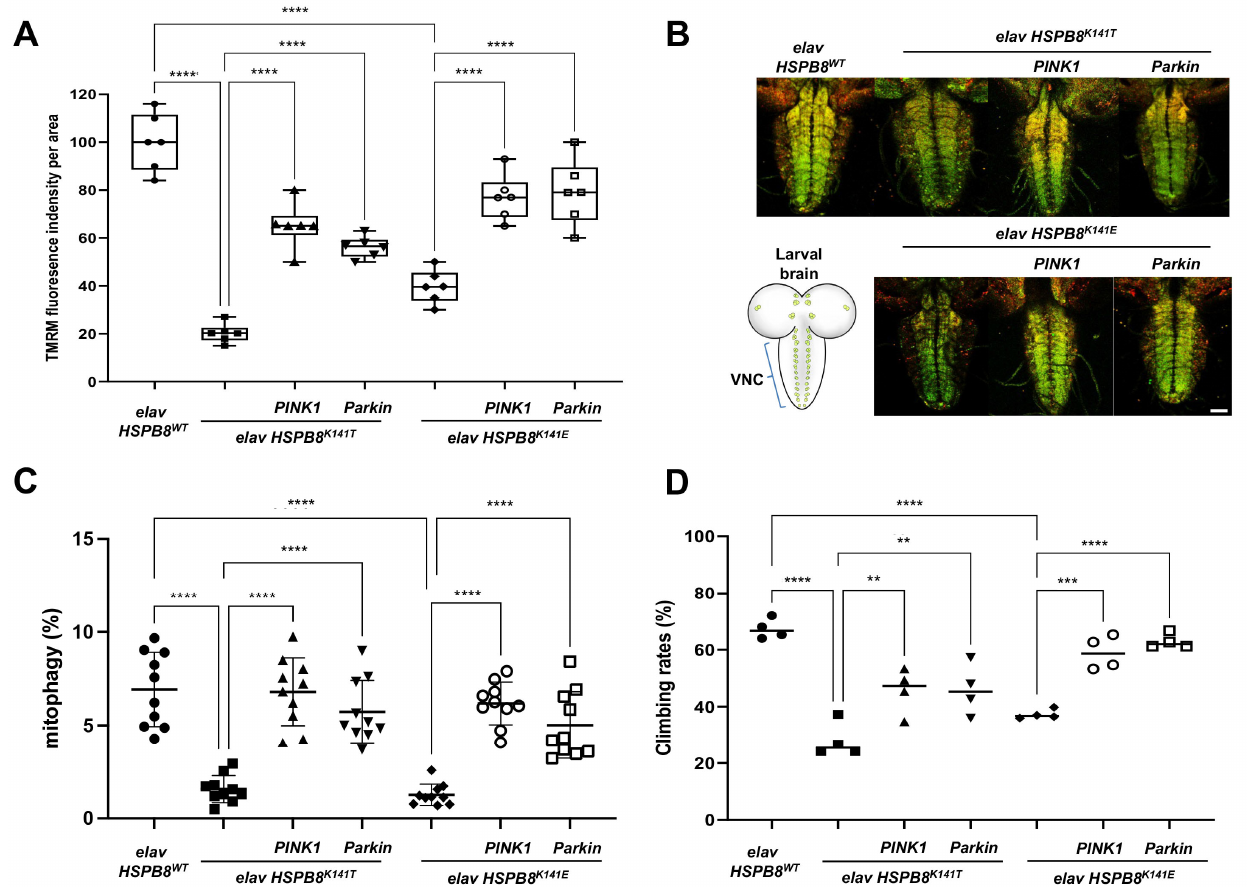
Figure 4. PINK1 and Parkin rescued mitochondrial defects induced by mutant HSPB8s. The following analyses were performed using wild ‐ type HSPB8 ‐ expressing ( elav HSPB8 WT ), mutant HSPB8 ‐ expressing ( elav HSPB8 K141T , elav HSPB8 K141E ), mutant HSPB8 ‐ and PINK1 ‐ expressing ( elav HSPB8 K141T PINK1 , elav HSPB8 K141E PINK1 ), mutant HSPB8 ‐ and Parkin ‐ expressing ( elav HSPB8 K141T Parkin , elav HSPB8 K141E Parkin ) flies: ( A ) Mitochondrial membrane potential ( ΔΨ m) was measured in larval VNCs ( n = 6 per group). ( B ) Representative mt ‐ Keima fluorescence images of larval VNCs. ( C ) Quantitative analysis of mitophagy in larval VNCs (n = 10 per group). ( D ) Comparison of the climbing ability of 15 ‐ day ‐ old male flies ( n = 4 per group). Significance was determined by Sidak test after one ‐ way ANOVA (**, p < 0.01; ***, p < 0.001; ****, p < 0.0001). Error bars indicate the mean ± SD. Scale bars: 50 μ m.